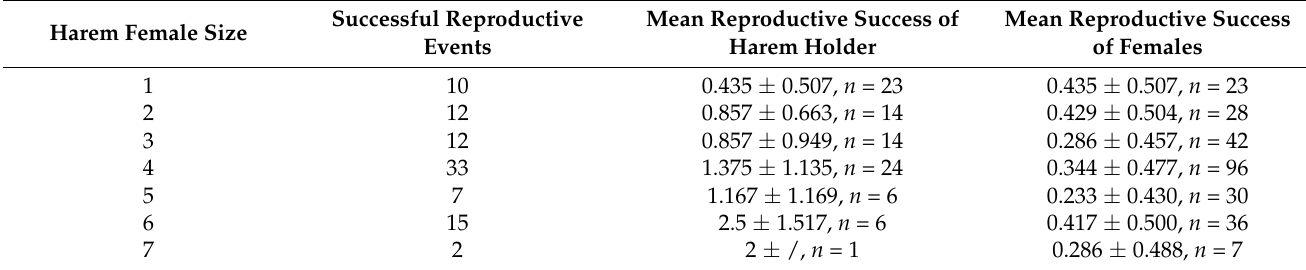
Table 2. Reproductive success (i.e., number of surviving infants) of harem holders and females in harems of different size. Harem Female